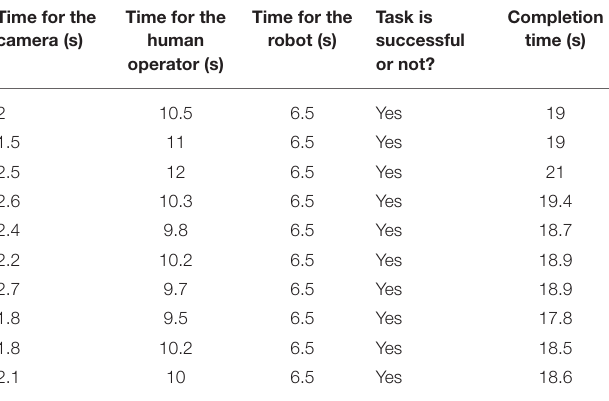
TABLE 2 | Cooperative assembly with cooperative shared control. Time for the camera